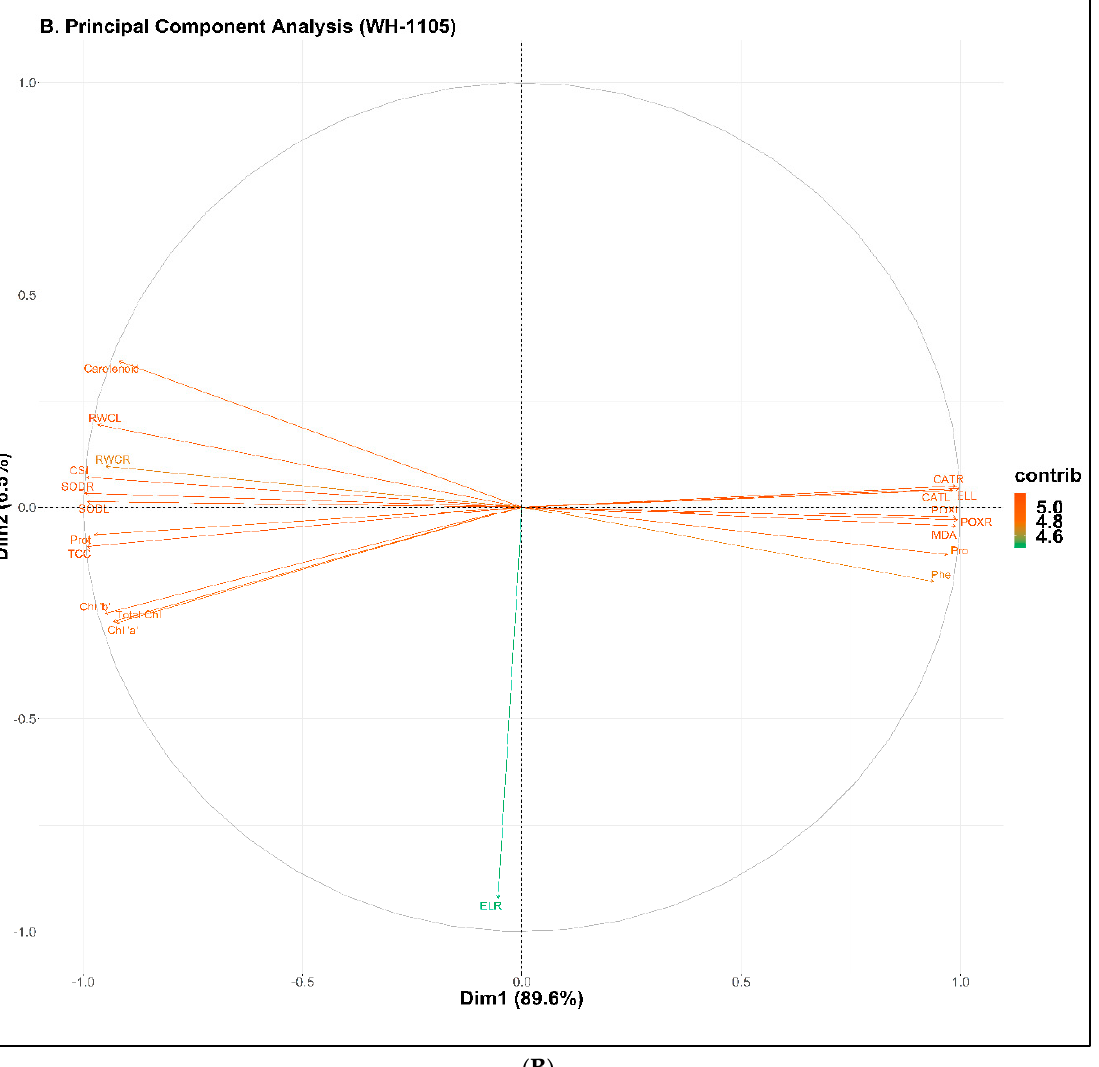
Figure 6. Plots of principal component analysis (PCA) on different studied parameters of KRL-210 ( A ) and WH-1105 ( B ) under different salinity levels with Si treatment. The abbreviations used in the figure are as follows: RWCR: relative water content of root, SODR: superoxide dismutase activity of root, RWCL: relative water content of leaves, CSI: chlorophyll stability index, TCC: total carbohydrate content, SODL: superoxide dismutase activity of leaves, Prot: protein content, Total chl: total chlorophyll, chl ‘a’: chlorophyll ‘a’, chl ‘b’: chlorophyll ‘b’, ELR: electrolyte leakage of root, Pro: proline content, Phe: phenol content, CATL: catalase activity of leaves, MDA, CATR: catalase activity of root, POXR: peroxidase activity of root, ELL: electrolyte leakage of leaves, POXL: peroxidase activity of leaves, Carotenoid: carotenoid content.